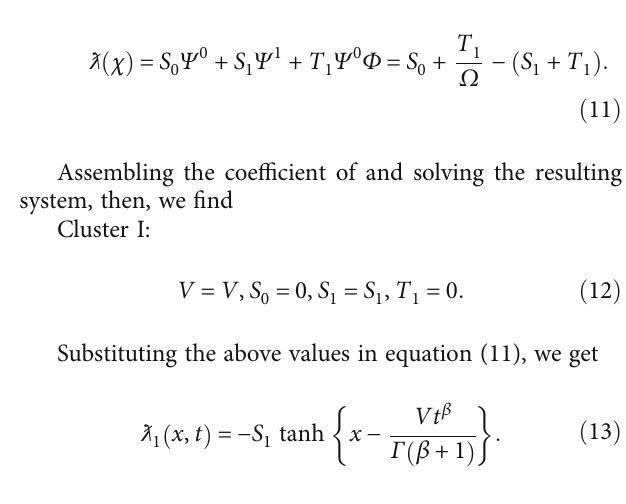
Figure 3: The graphical representation of the solution ƛ (c) real contour plot, and (d) imaginary contour